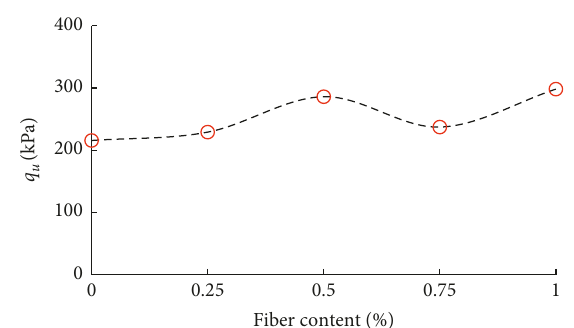
Figure 14: Peak strength q u of slurry with various fiber